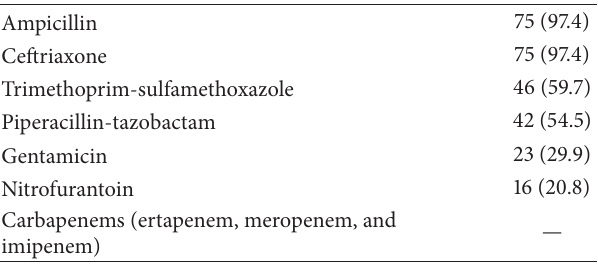
Table 3: Resistance rates of Enterobacteriaceae strains against antimicrobial agents, 𝑛